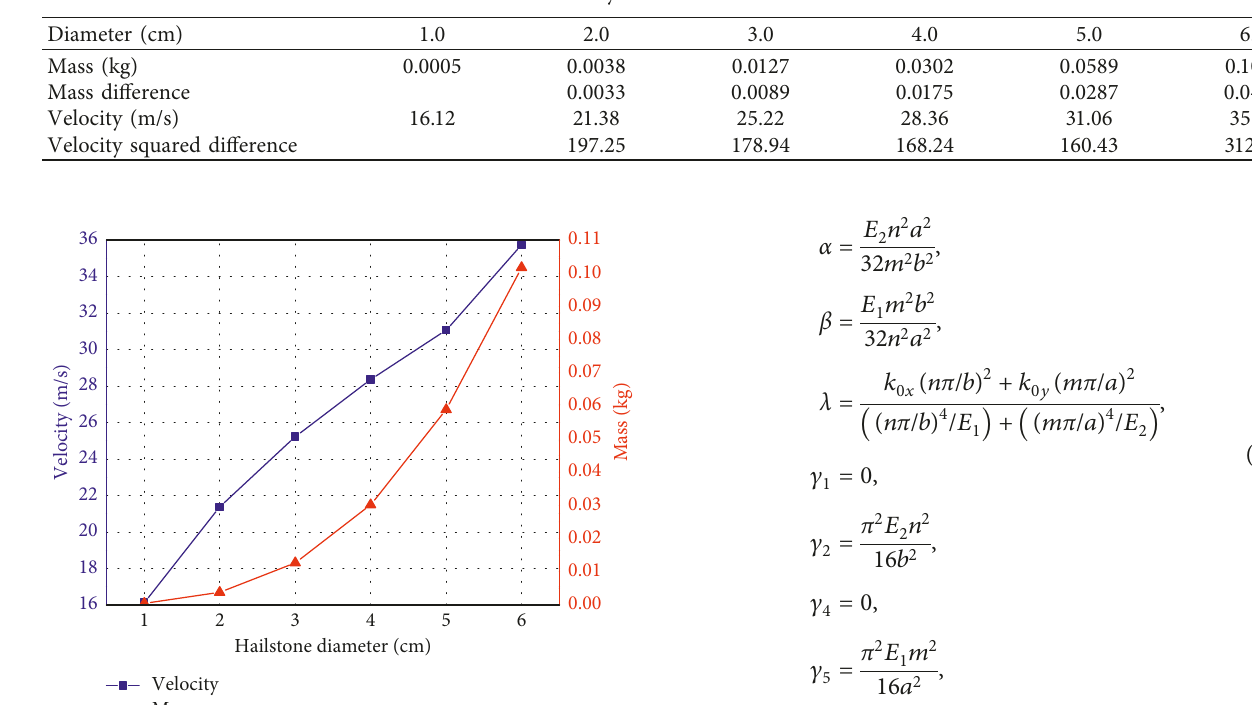
Table 1: Mass and velocity of hailstone with different diameters.